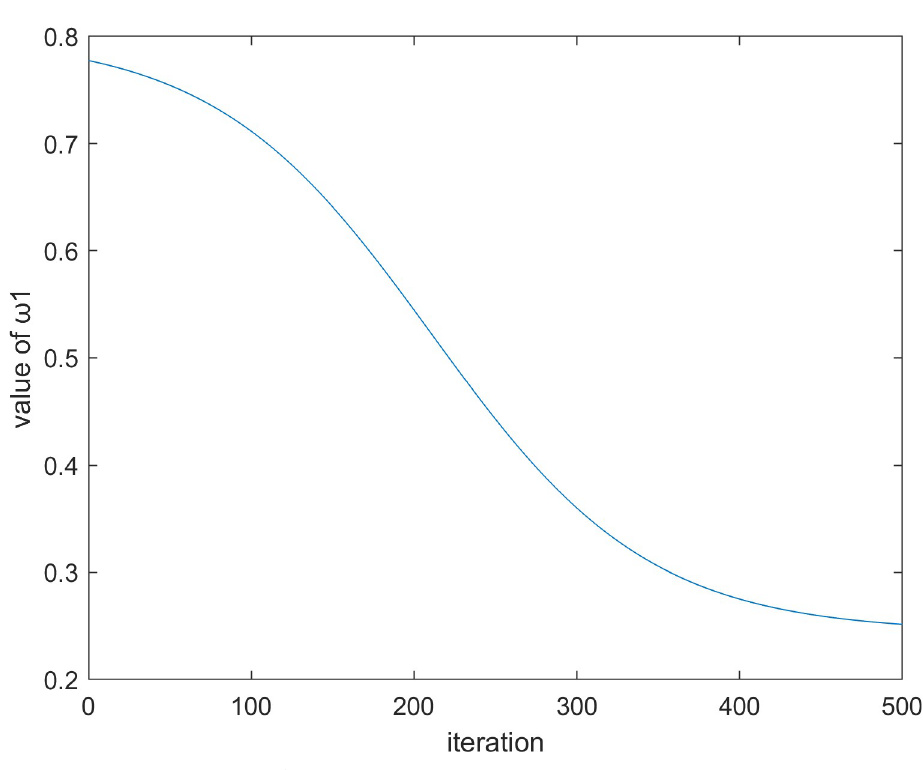
Fig 2. The iteration diagram of ω t